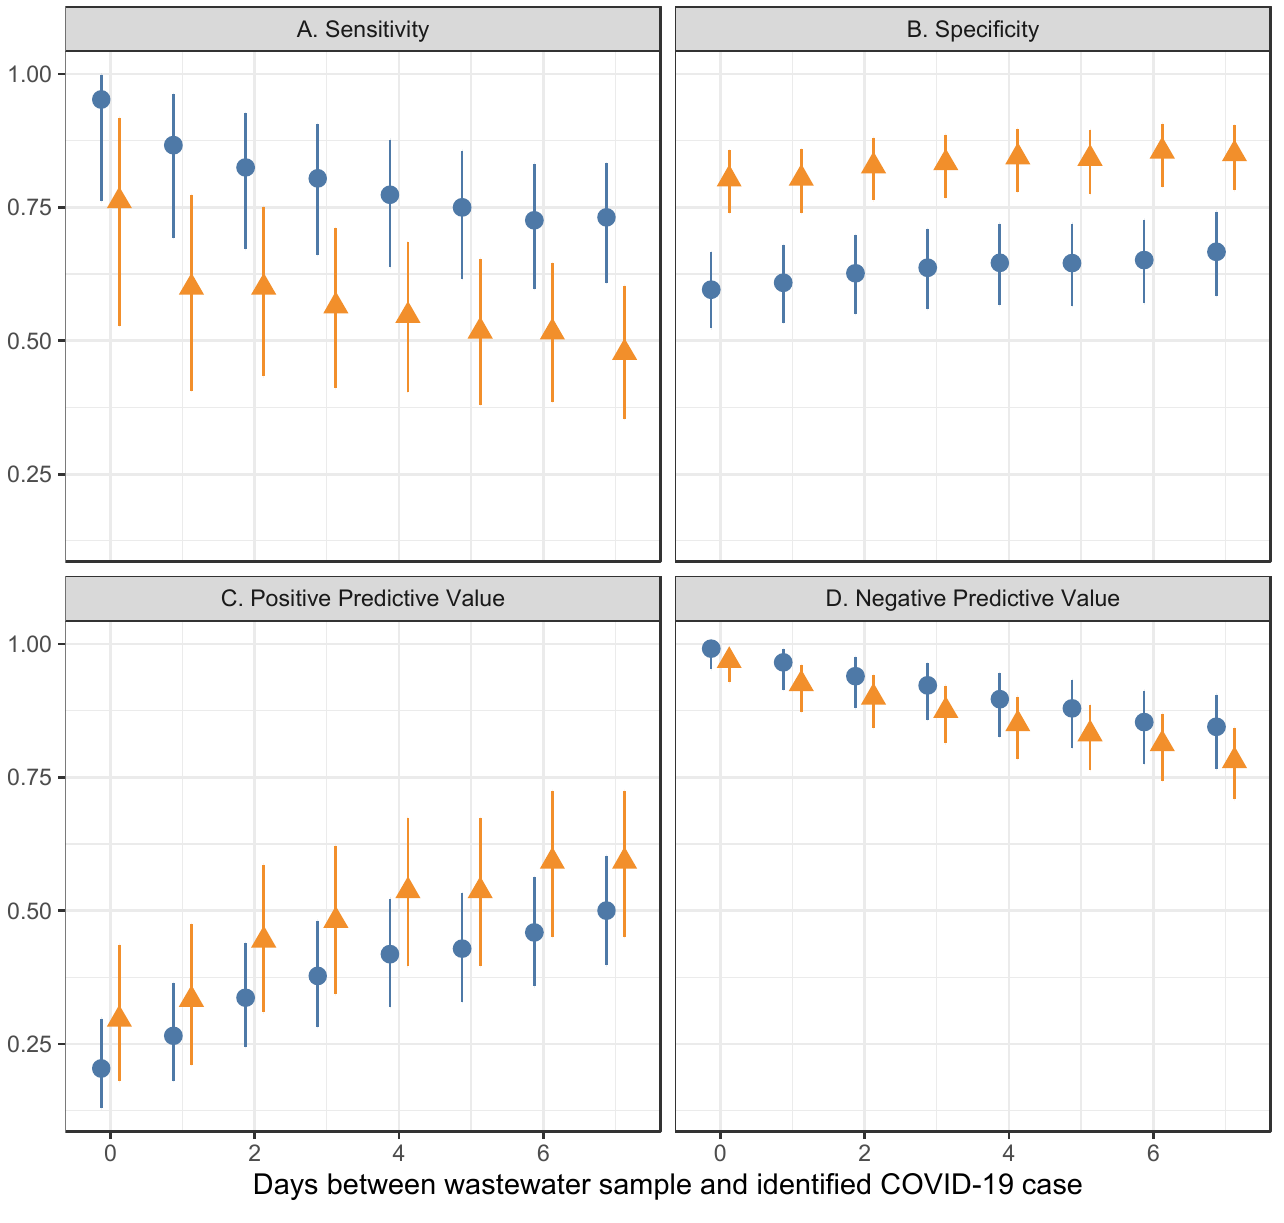
Figure 5. Sensitivity ( A ) to identify a building with a COVID-19 case using wastewater surveillance, specificity ( B ) to identify a building without a COVID-19 case using wastewater surveillance, positive predictive value ( C ) of a positive wastewater surveillance result to indicate a COVID-19 case among residents, and negative predictive value ( D ) of a negative wastewater surveillance result to indicate no COVID-19 cases among residents.